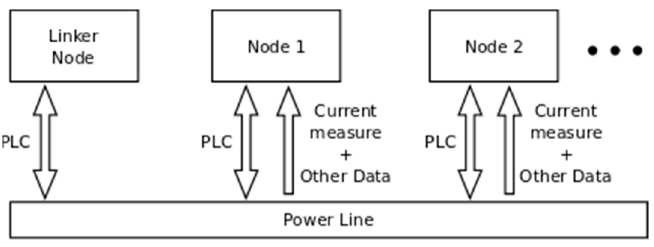
Figure 6. Proposed sensor network architecture.